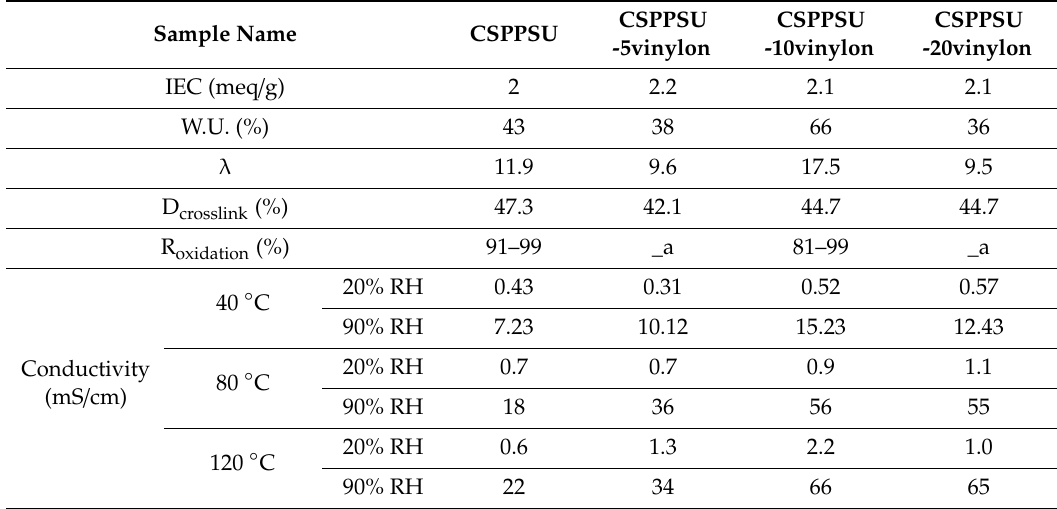
Table 5. Physicochemical and conductivity properties of the CSPPSU-vinylon